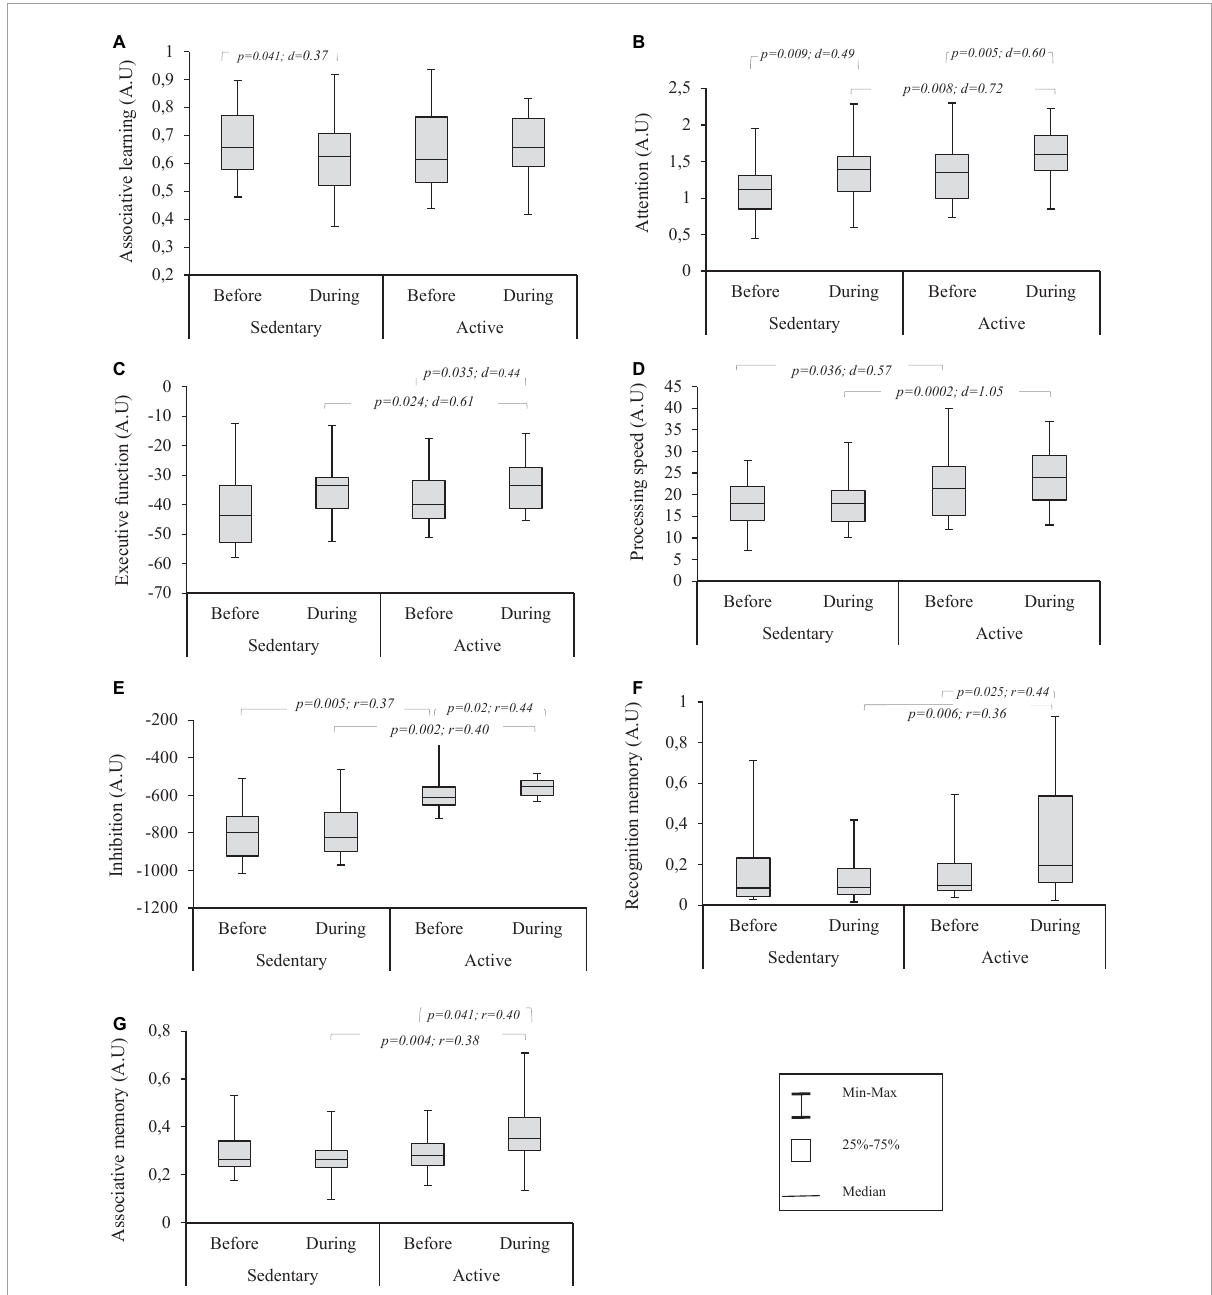
FIGURE2 Box plots distribution of recognition memory (A) , associative memory (B) , inhibition (C) , processing speed (D) , associative learning (E) , executive function (F) and attention (G) assessed using Neurotrack’s digital cognitive battery in sedentary and active groups before and during Ramadan